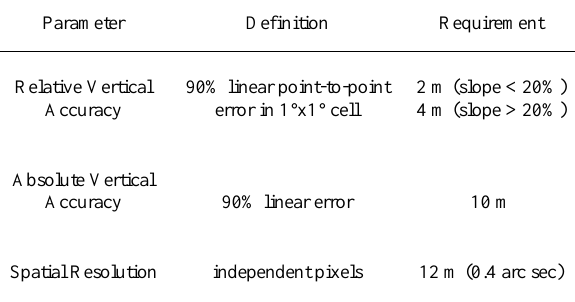
in close formation. Table 1. Specification of the Global TanDEM-X